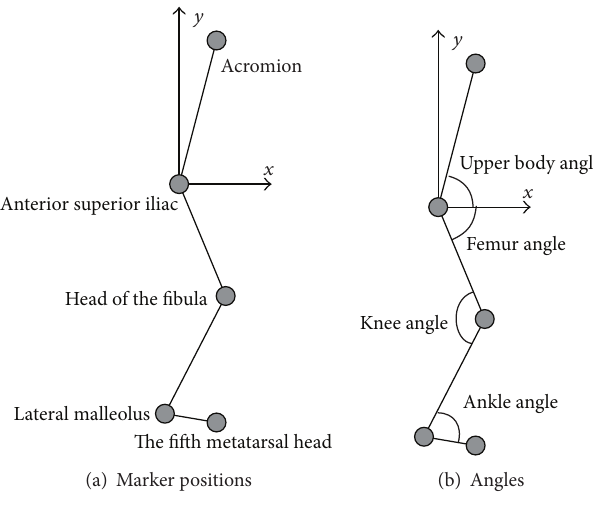
Figure 2: Coordinate frame, marker positions, and angles.